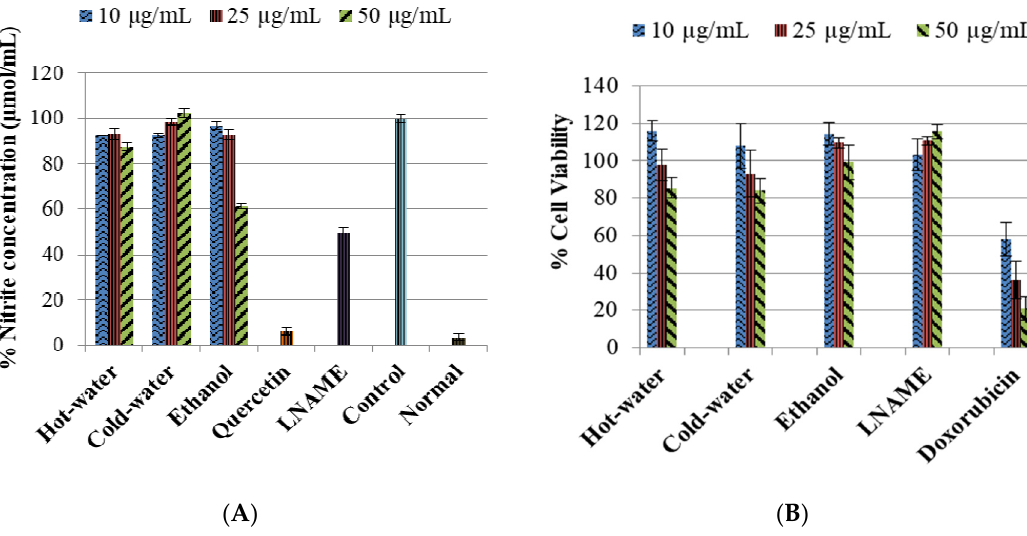
Figure 1. The inhibitory effect of P. natalensis extracts on LPS-induced NO production ( A ) and % cell viability ( B ) on RAW 264.7 macrophages treated with different concentrations (10, 25 and 50 µg/mL) and positive controls; for Figure 1A: quercetin (50 µg/mL), N-Nitro-L-Arginine Methyl Ester (LNAME) (100 µM) and for Figure1B: LNAME (25, 50 and 100 µM) and doxorubicin (4, 10 and 20 µM) over 24 h.